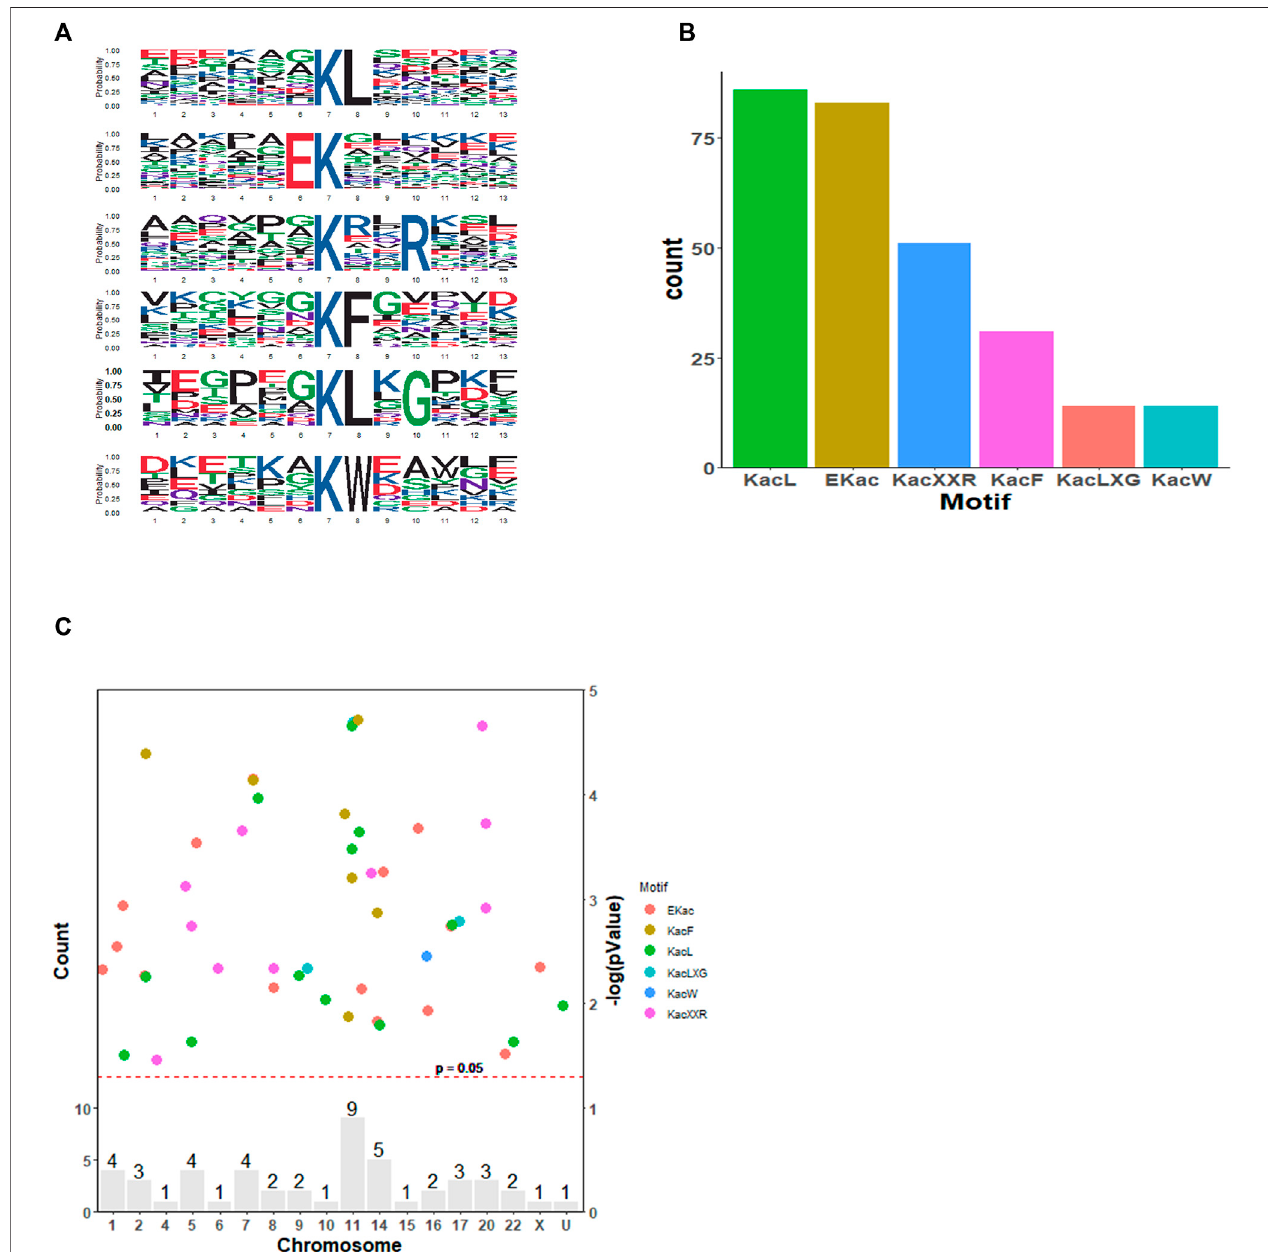
FIGURE 2 | Motif analysis of the identi fi ed acetylation peptides in SAHA-treated cells. (A) Sequence logo of acetylated motifs. (B) Number of identi fi ed peptides containing acetylated lysine in each motif. (C) Distribution of acetylated proteins across chromosomes. The red dashed line corresponds to p = 0.05 , and the peptide sites (dots)above this threshold are shown in different colors according to their motifs. The bars indicate the total number of acetylated sites in each chromosome. U, undetermined.